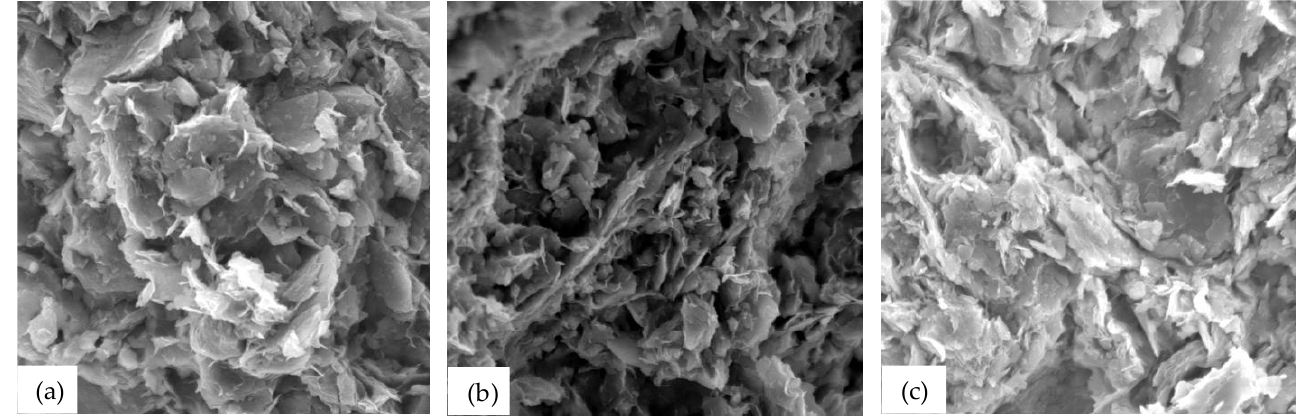
Figure 8. Typical SEM images: ( a ) Remolded soil; ( b ) Anodic soil of T1; ( c ) Anodic soil of T2.